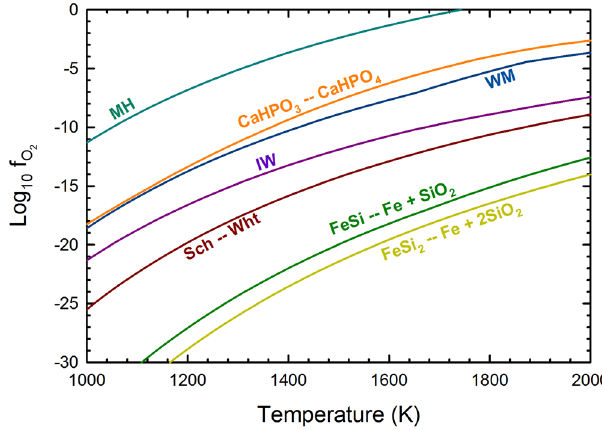
Fig. 5 Oxygen fugacity diagram. Oxygen fugacity is buffered by minerals (MH magnetite/hematite, WM wustite/magnetite, IW iron/wustite) that demonstrates the reduction of calcium phosphate to calcium phosphite (CaHPO 3 – CaHPO 4 ) should occur at much higher f O2 than other reduction reactions, including the transformation of schreibersite (Sch, nominally Fe 3 P) to whitlockite (wht, nominally Ca 3 (PO 4 ) 2 ). The transformation of whitlockite to schreibersite should also occur readily if silicates are reduced to